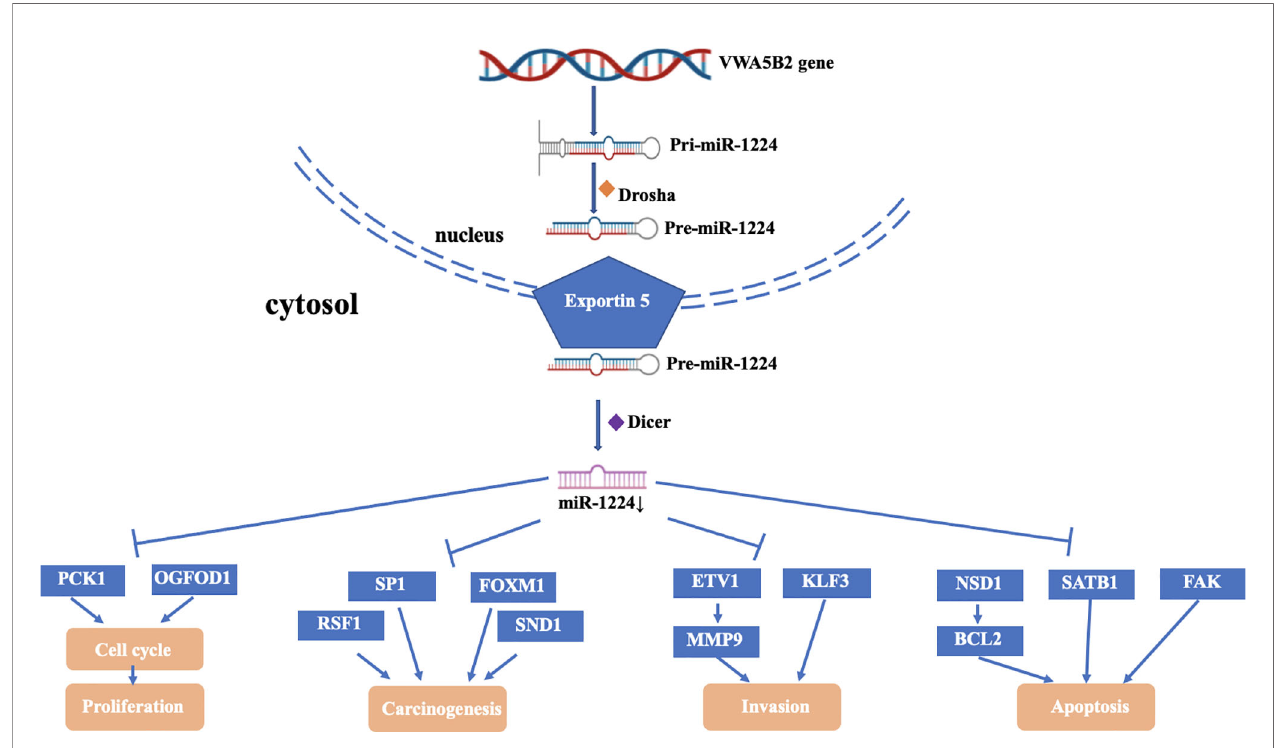
FIGURE 1 | Mechanism and function of miR-1224 downregulation in